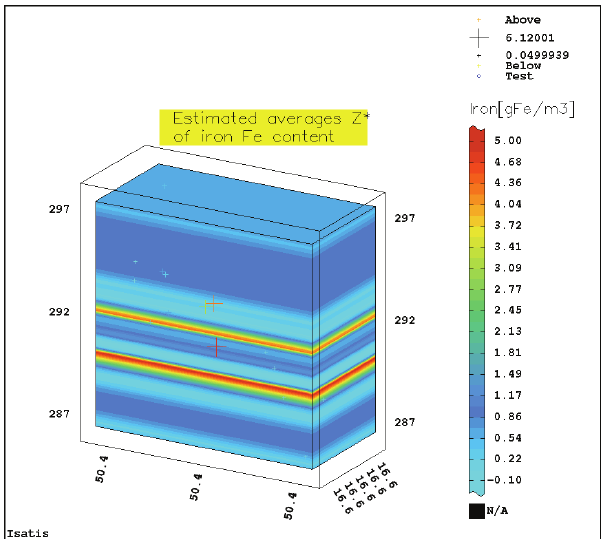
Fig. 25. Block diagram of estimated averages Z * distribution of